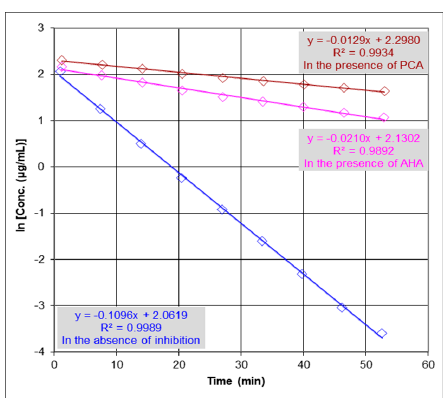
Figure 3. Anti-urease activity of protocatechuic acid (PCA) and acetohydroxamic acid (AHA) evaluated by an Electrospray Ionization-Mass Spectrometry (ESI-MS) based method. k 0 is the reaction